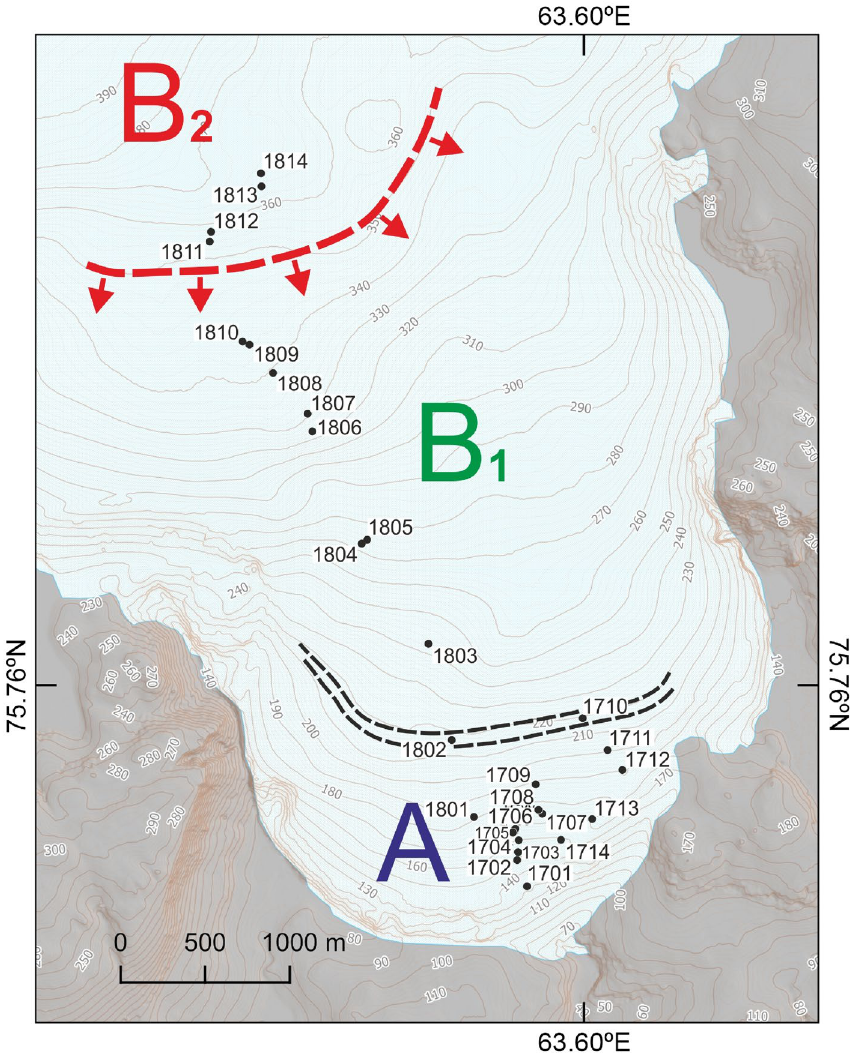
Figure 2. Location of sampling points on Nalli Glacier. A— 137 Cs activity zone < 440 Bq kg −1 ; B 1 — 137 Cs activity zone 2700–4660 Bq kg −1 ; B 2 — 137 Cs activity zone 5700–8100 Bq kg −1 . The black dashed lines indicate the narrow transitional area between zones A and B. The red dashed line with arrows represents the frontal part of secondary radioactive contamination (see text for details). 1701–1714—samples collected in 2017; 1801–1814— samples collected in 2018. The relief and contours were obtained from ArcticDEM. DEM(s) were created from DigitalGlobe, Inc., imagery and funded under National Science Foundation awards 1043681, 1559691, and 1542736. The elevation map was created using QGIS 3.16 (https:// www. qgis. org). The figure was created using Corel Draw X7 software (https:// www. corel draw.